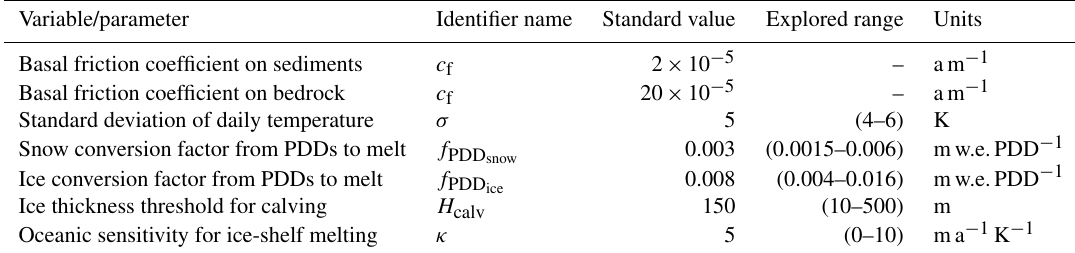
Table 1. Model parameters used in this study with their standard and explored values.